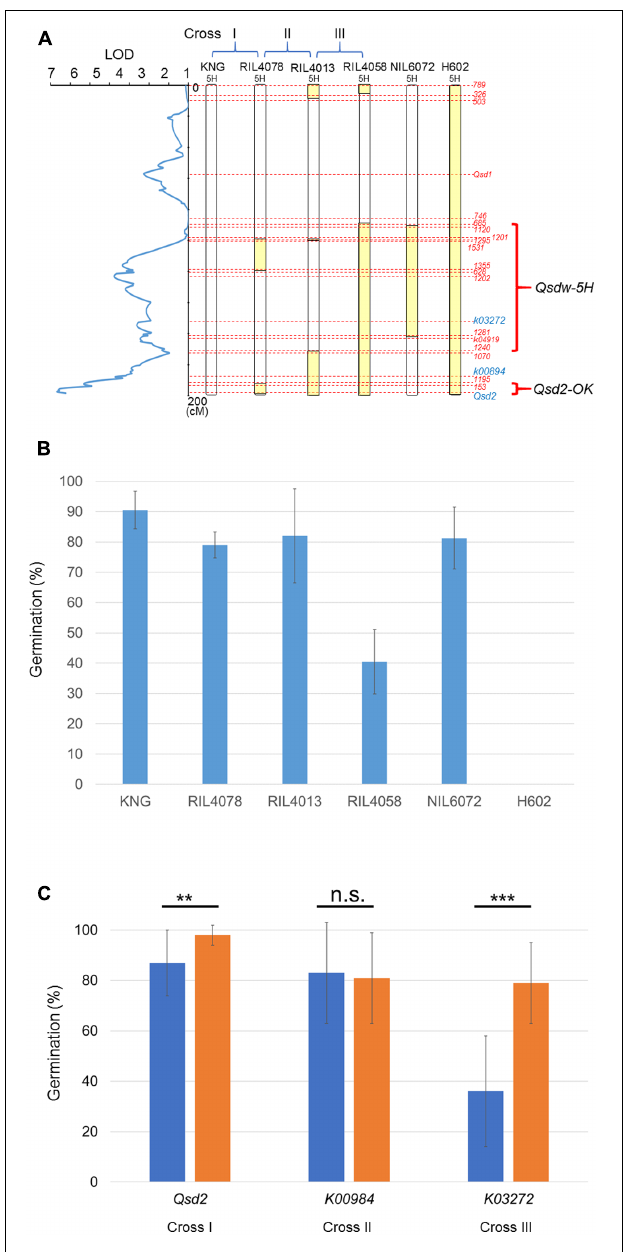
FIGURE 3 | Association analysis between phenotypes and genotypes in the F 2 progenies. (A) Genotypes of the parental lines. Graphical genotypes of chromosome 5H. The results of QTL analysis in 2010 using SIM are displayed on the left. LOD, logarithm of odds. cM, centiMorgan. Yellow bars: H602-homozygous genomic region. Open bars: KNG-homozygous genomic region. Blue letters: DNA markers names used for association analysis. Red letters: DNA marker names. The QTL regions estimated from the association analysis are shown on the right. (B) Phenotypes of the parental lines. Germination percentages. The germination test was performed using samples harvested in 2015. Blue bars: mean germination percentages. Vertical bars: standard deviation. n = 3 spikes. (C) Analysis of the mean germination percentages of F 3 grains derived from F 2 plants with homozygous H602 or KNG genotypes at the DNA markers. The germination test was performed using samples harvested in 2015. The F 2 plants were derived from (Continued)